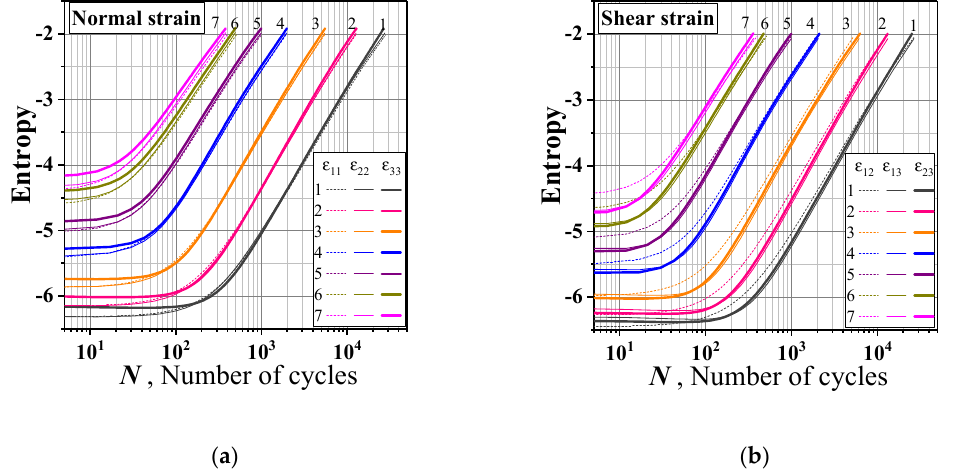
Figure 6. The curves of differential entropies at different strain amplitude cycle vs. cycle number: